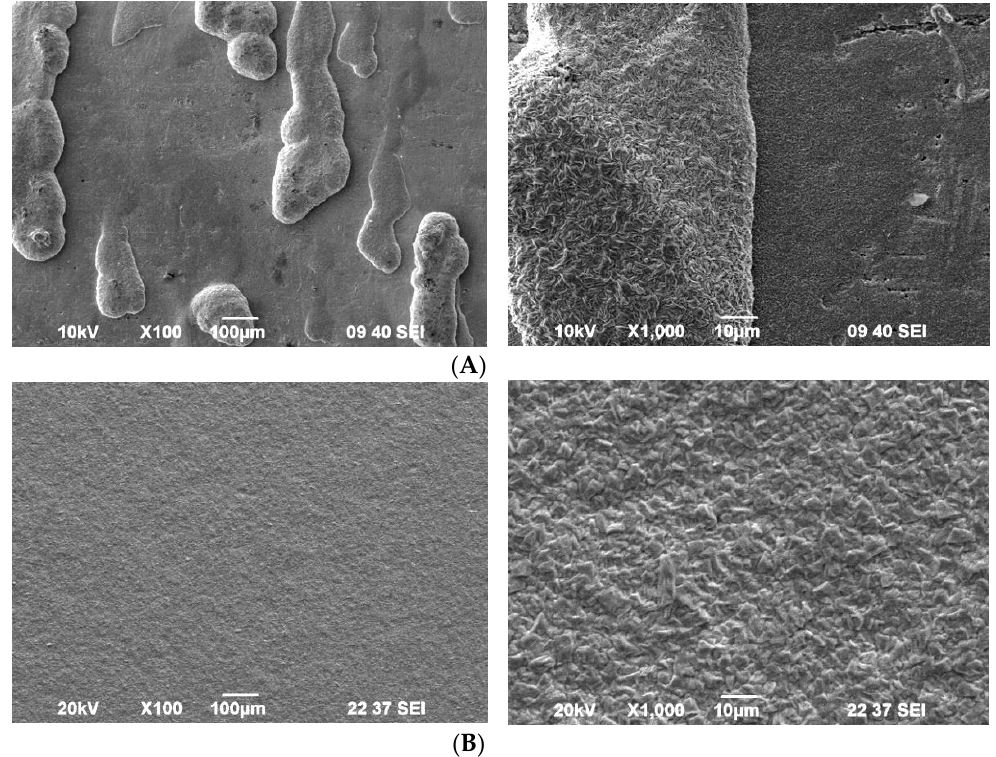
Figure 2. SEM images of Zn-PANI hybrid coatings at two magnifications: ( A )—Zn-PANI / PVP; ( B )—Zn-PANI / SiO 2 .